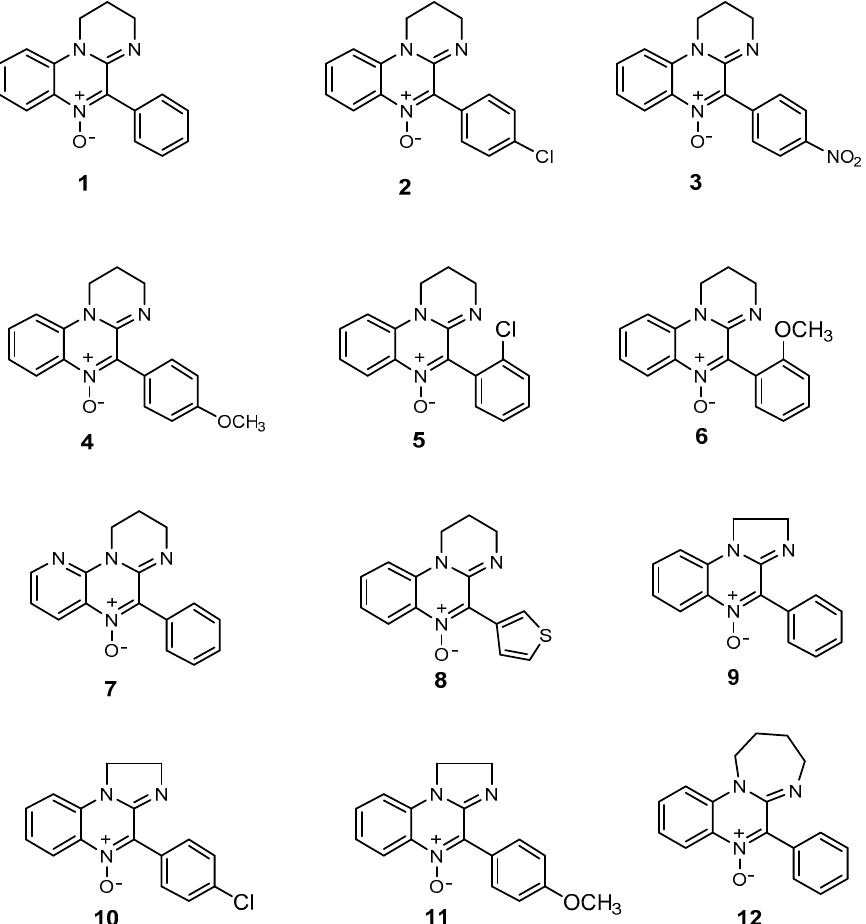
Figure 1. Structure of amidinoquinoxaline-based nitrones.